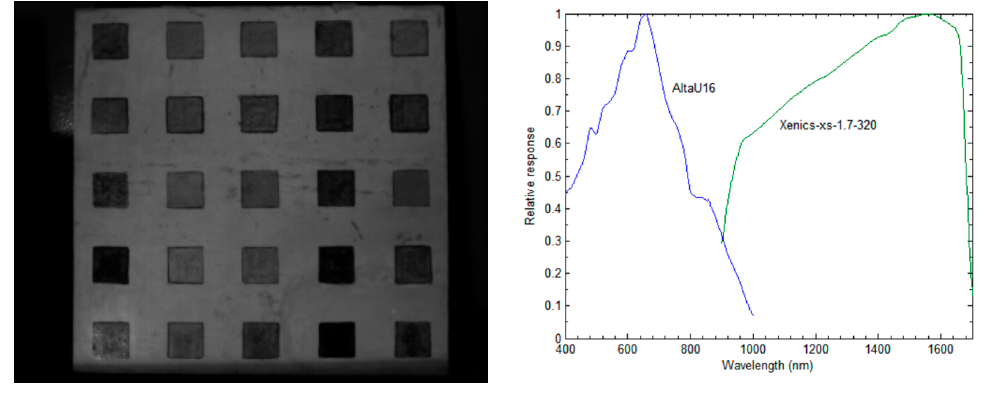
Figure 3. ( a ) Color matrix as seen by Xenics-XS camera; ( b ) Responsivities of two cameras from 800